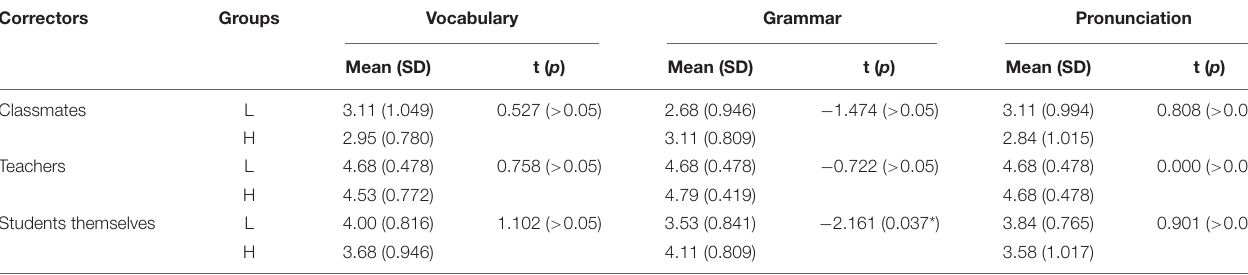
TABLE 4 | High- (H) and low-accuracy (L) group responses to choice of correctors. Correctors Groups